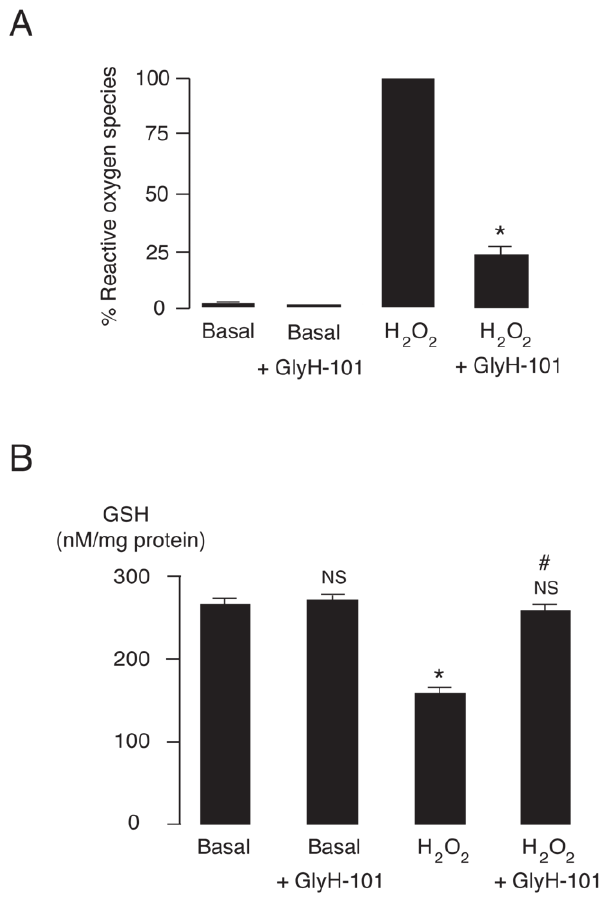
Figure 2. Anti-oxidative properties of GlyH-101 in erythrocytes of beta thalassemia/Hb E patients. (A) Amelioration by GlyH-101 of free radical production induced by H 2 O 2 exposure. Erythrocytes loaded with DCFH-DA were incubated for 1 h without (basal) or with H 2 O 2 (10 mM) in the presence or absence of GlyH-101 (50 m M). Reactive oxygen species were measured by flow cytometry analysis at excitation wavelength of 490 nm and emission wavelength of 530 nm. Data were expressed as means 6 S.E. *, p , 0.001 compared with H 2 O 2 -treated group (n=12). (B) Effect of GlyH-101 on intracellular glutathione levels. Erythrocytes were treated for 1 h without (basal) or with H 2 O 2 (10 mM) in the presence or absence of GlyH-101 (50 m M) before measurements of GSH levels. Data were expressed as means 6 S.E. NS, non-statistical significant difference from basal control; *, p , 0.01 compared with basal control; # , p , 0.01 compared with H 2 O 2 -treated group (n=12). abolished the effect of H 2 O 2 on erythrocyte GSH levels (248.45 6 7.28 nM/mg protein).